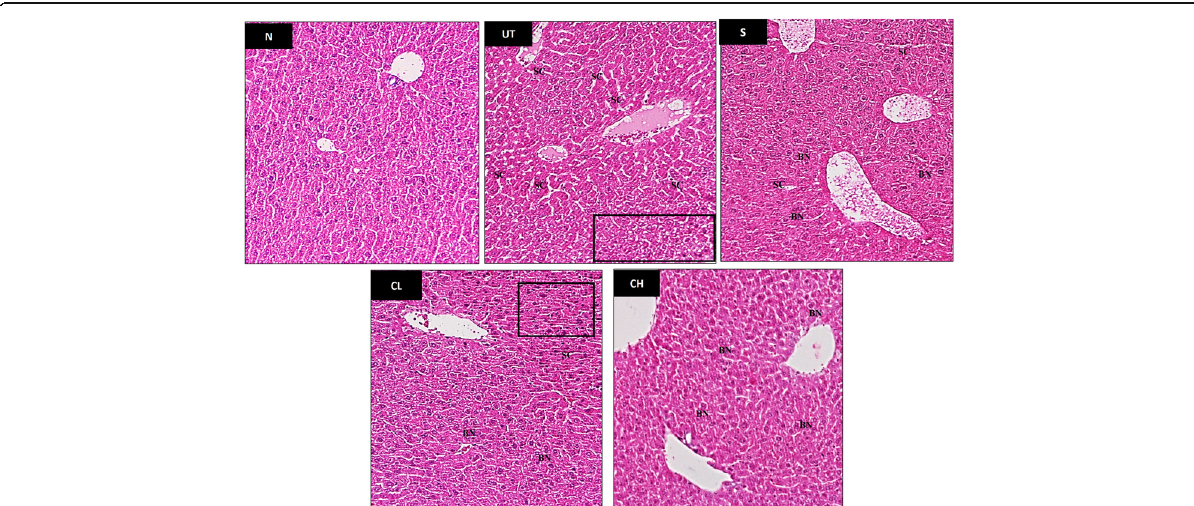
Fig. 1 Effect of coconut water vinegar against acetaminophen-induced liver histopathological changes in mice (magnification 200×). N: Liver from normal control mice with normal histological appearance. UT: Untreated acetaminophen challenged mice with pyknotic nuclei (rectangle), and di- lated sinusoidal (SC). S: Silybin treated acetaminophen challenged mice and CL: 0.08 ml/kg BW coconut vinegar treated acetaminophen chal- lenged mice showed reduced number of dilated sinusoidal (SC) and increasing binuclear hepatocyte (BN) comparing to UT. CH: 2 ml/kg BW coconut vinegar treated acetaminophen challenged mice histological appearance similar to normal control mice with higher incidence of binuclear